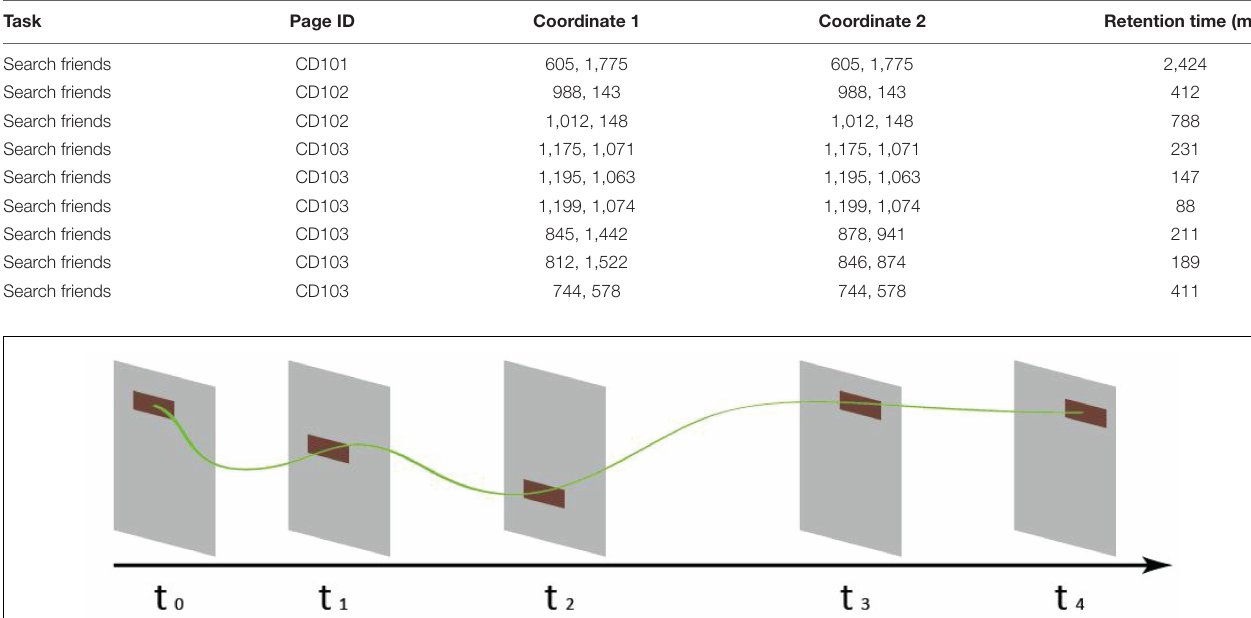
TABLE 2 | User behavior records for searching friends on “Waterman.”